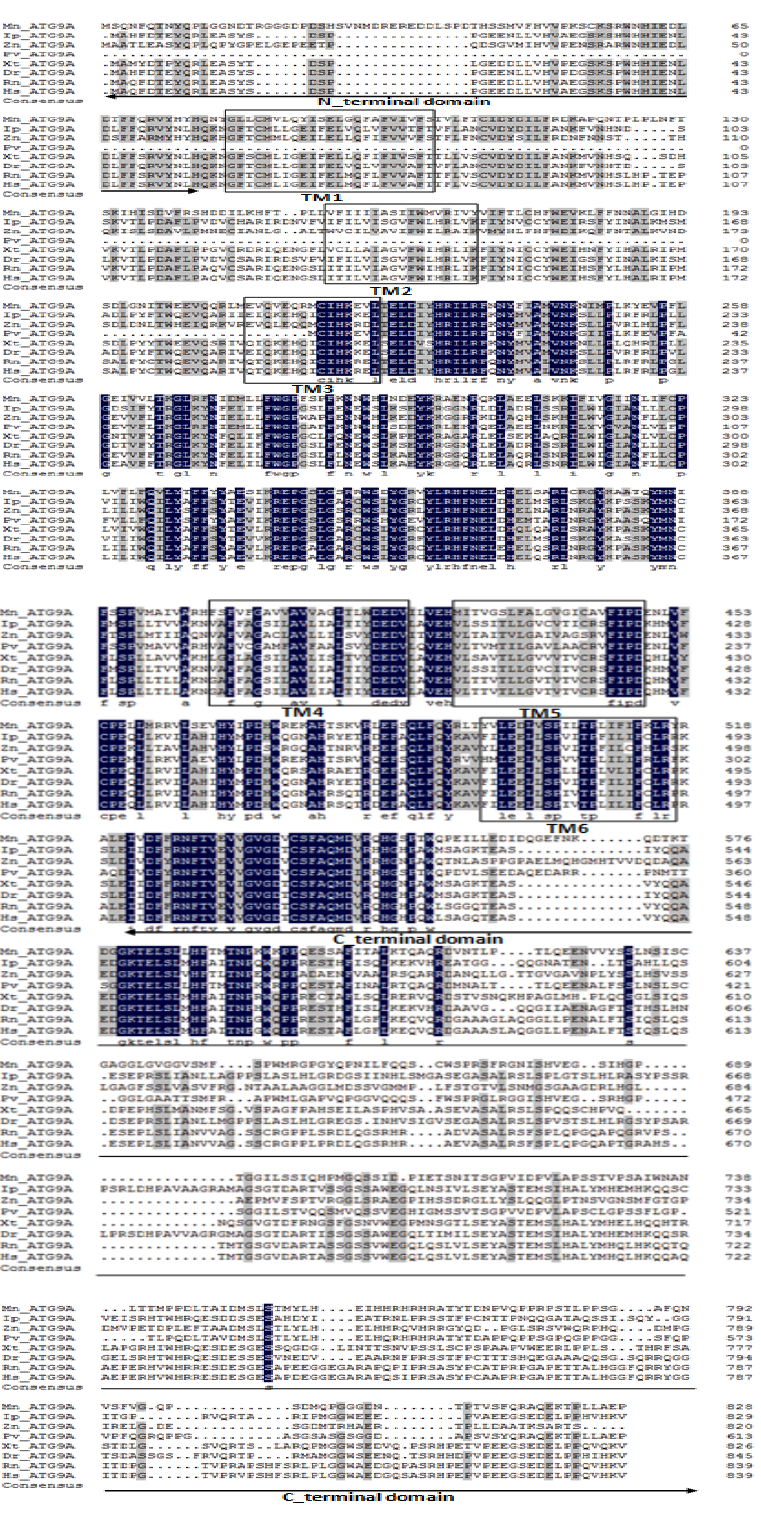
Figure A4. Multiple amino acid sequence alignment of ATG9A from Macrobrachium nipponensis and other species. The accession numbers for ATG9A from Macrobrachium nipponensis (Mn), Ictalurus punctatus (Ip), Zootermopsis nevadensis (Zn), Penaeus vannamei (Pv), Xenopus tropicalis (Xt), Danio rerio (Dr), Rattus norvegicus (Rn) and Homo sapiens (Hs) are MK296402, XP_017337852.1, XP_021928466.1, ROT68153.1, XP_012826405.1, NP_001076500.1, AAH89204.1, and NP_076990.4 respectively. The arrows below the sequences indicate the conserved domains (N-terminal domain and C-terminal domain). The six transmembrane helices (TM) are